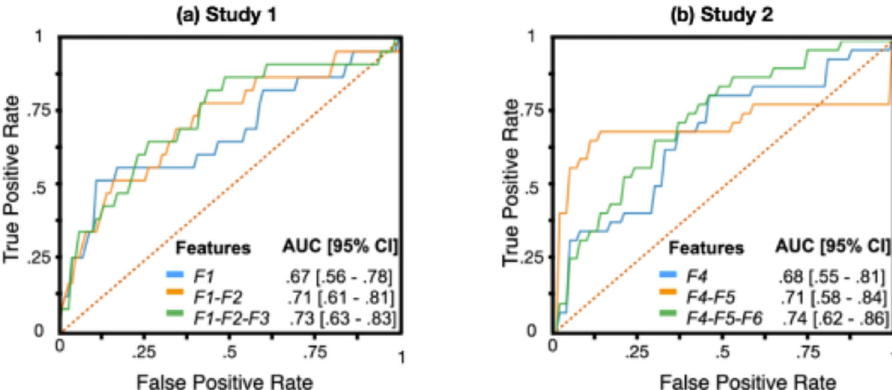
Fig. 4 Receiver operating characteristic (ROC) curves and areas under the curve (AUC). ROCs and AUCs were obtained using logistic regression classi fi ers trained on a single, two, and three features, when differentiating autistic and neurotypical toddlers in study 1 (left) and autistic children aged 3-10 years with and without co-occurring ADHD in study 2 (right) samples. In both studies, level of group discrimination improves when adding features to the model. Con fi dence intervals were computed with the Hanley and McNeil method at 95% level. F1: Average length [mm]; F2: Average touch duration [s]; F3: Average time spent [s]; F4: Average distance to the center [mm]; F5: Number of targets ]; F6: Screen exploratory percentage .